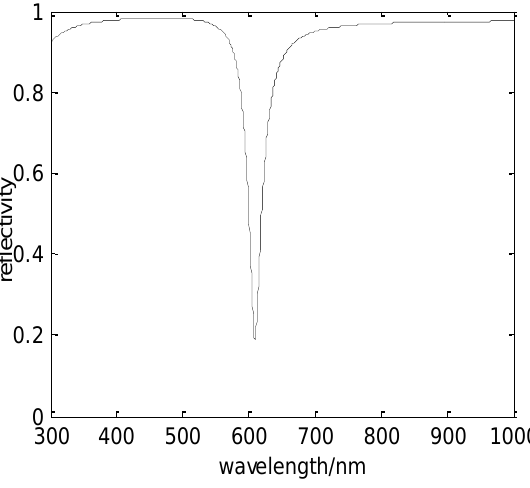
Figure 4. Simulation spectrum of an SPR sensor based on a silica-core multimode optical